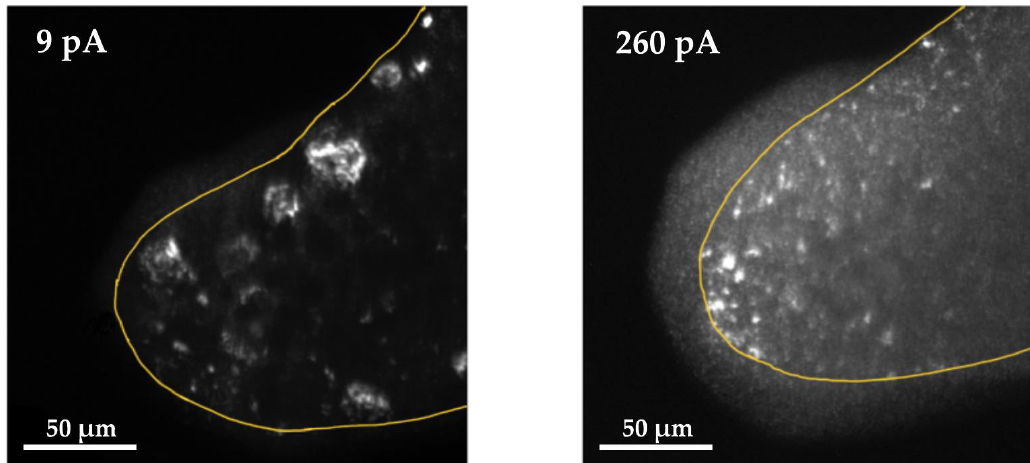
Figure 10. TEM analysis of two FIB-PtC tips shows the difference in distribution of carbon (dark) and platinum (bright) in the material structure depending on the chosen ion current. Left: 9 pA ion current. Right: 260 pA ion current. The accumulation outside the edge of the tip is caused by the deposition of C-H during the TEM analysis.